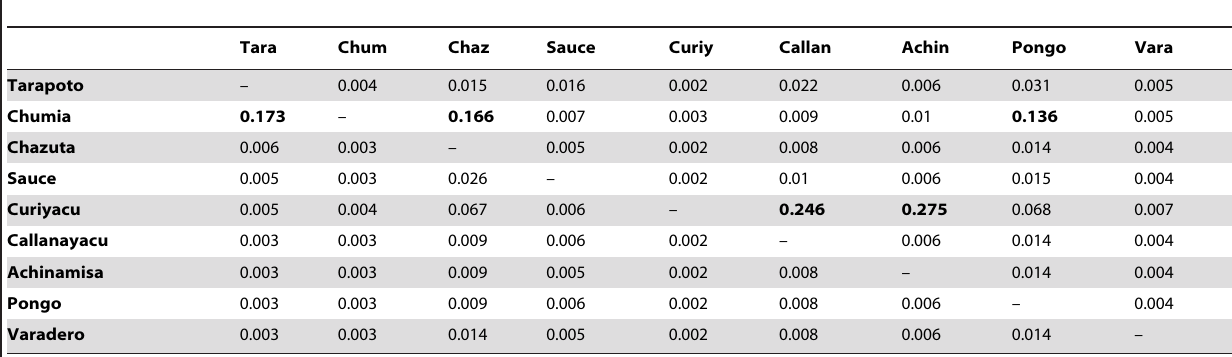
Table 1. Rate of recent gene flow ( m ) derived from the program BAYESASS (Wilson & Ranala